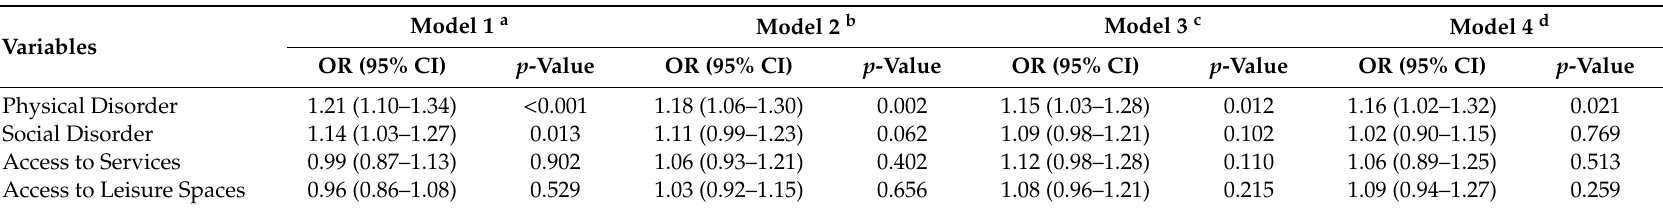
Table 3. Odds ratios of self-rated health associated with the area level characteristics before and after adjustment for covariates, CAF Survey,